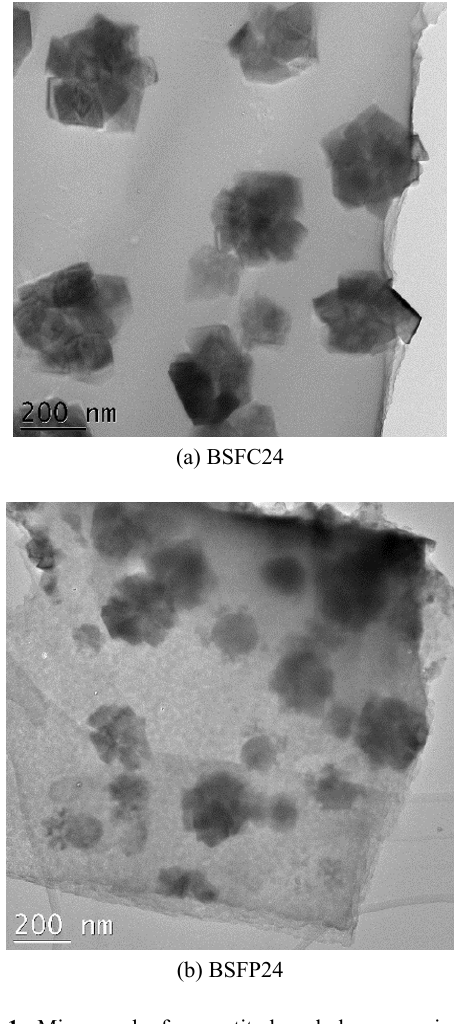
Fig. 1 Micrograph of magnetite-based